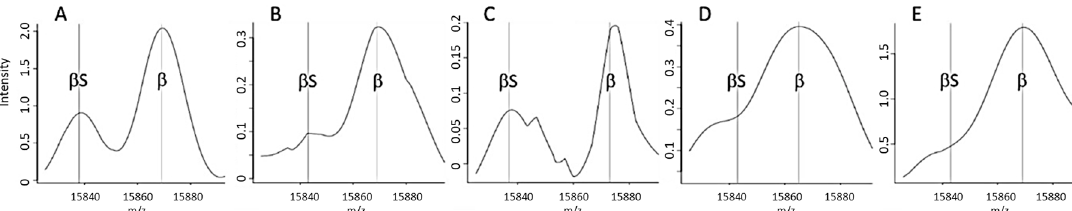
Figure 4. Examples of spectra tagged by an alert from set 2. ( A ) Standard FAS spectrum without an alert, ( B ) A spectrum tagged by an FAS-d alert: abnormally weak signal intensity for the β S chain, ( C ) A spectrum tagged by an FAS-e alert: insu ffi cient resolution of the β S peak, ( D ) A spectrum tagged by an FAS-f alert, indicating an insu ffi cient resolution of the β S and β A peaks, ( E ) Spectrum tagged by an FAS-g alert, corresponding to an abnormal β S: β A peak ratio.